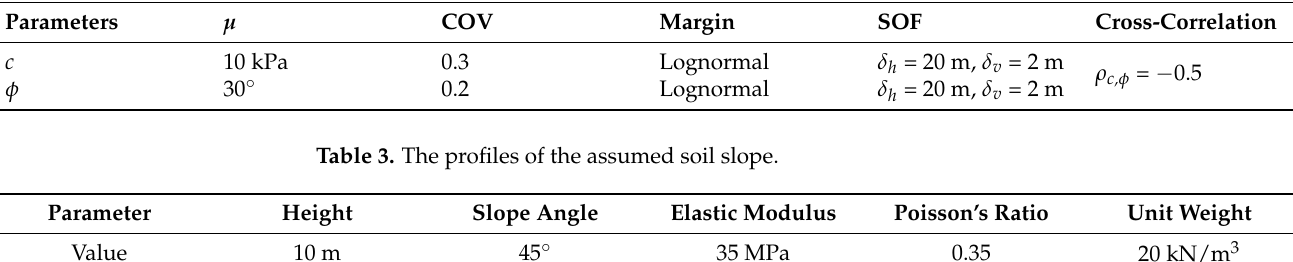
Figure 3. Assumed c - ϕ slope. Table 2. Statistics and random field parameters of the assumed soil slope.